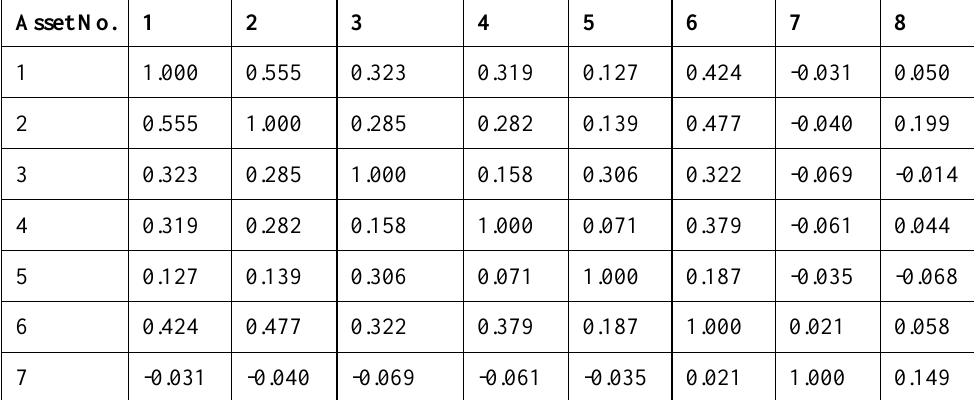
Table 2. The first scenario for the correlation coefficient matrix Asset